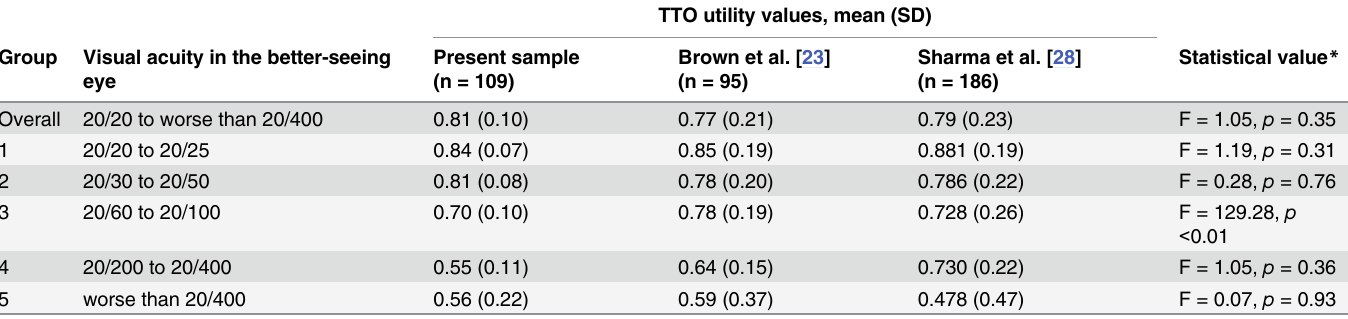
Table 7. Comparison of the time trade-off utility values from our sample with similar samples taken in the United States and